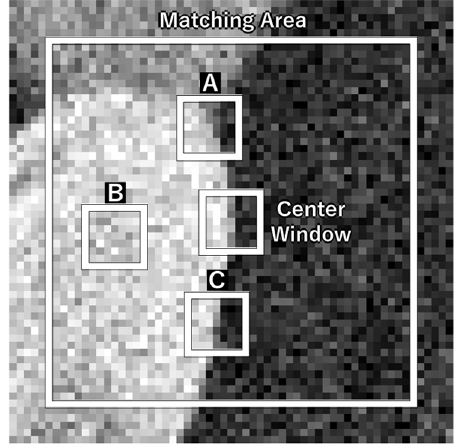
Figure 1. Example of image matching on test image.